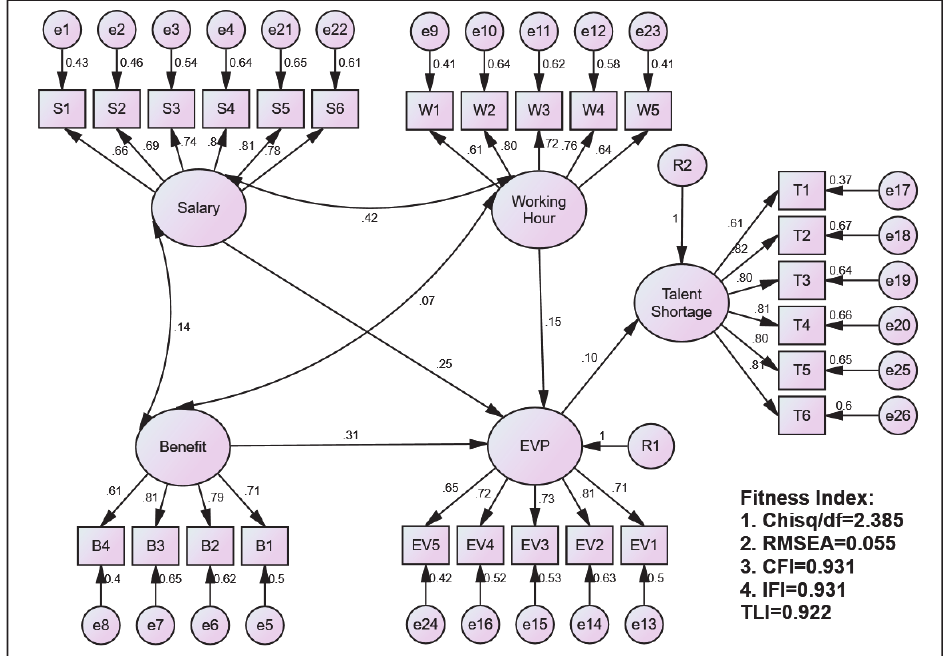
Fig. 3 and Table 2 present the results of the implementation of SEM for the standardized model.